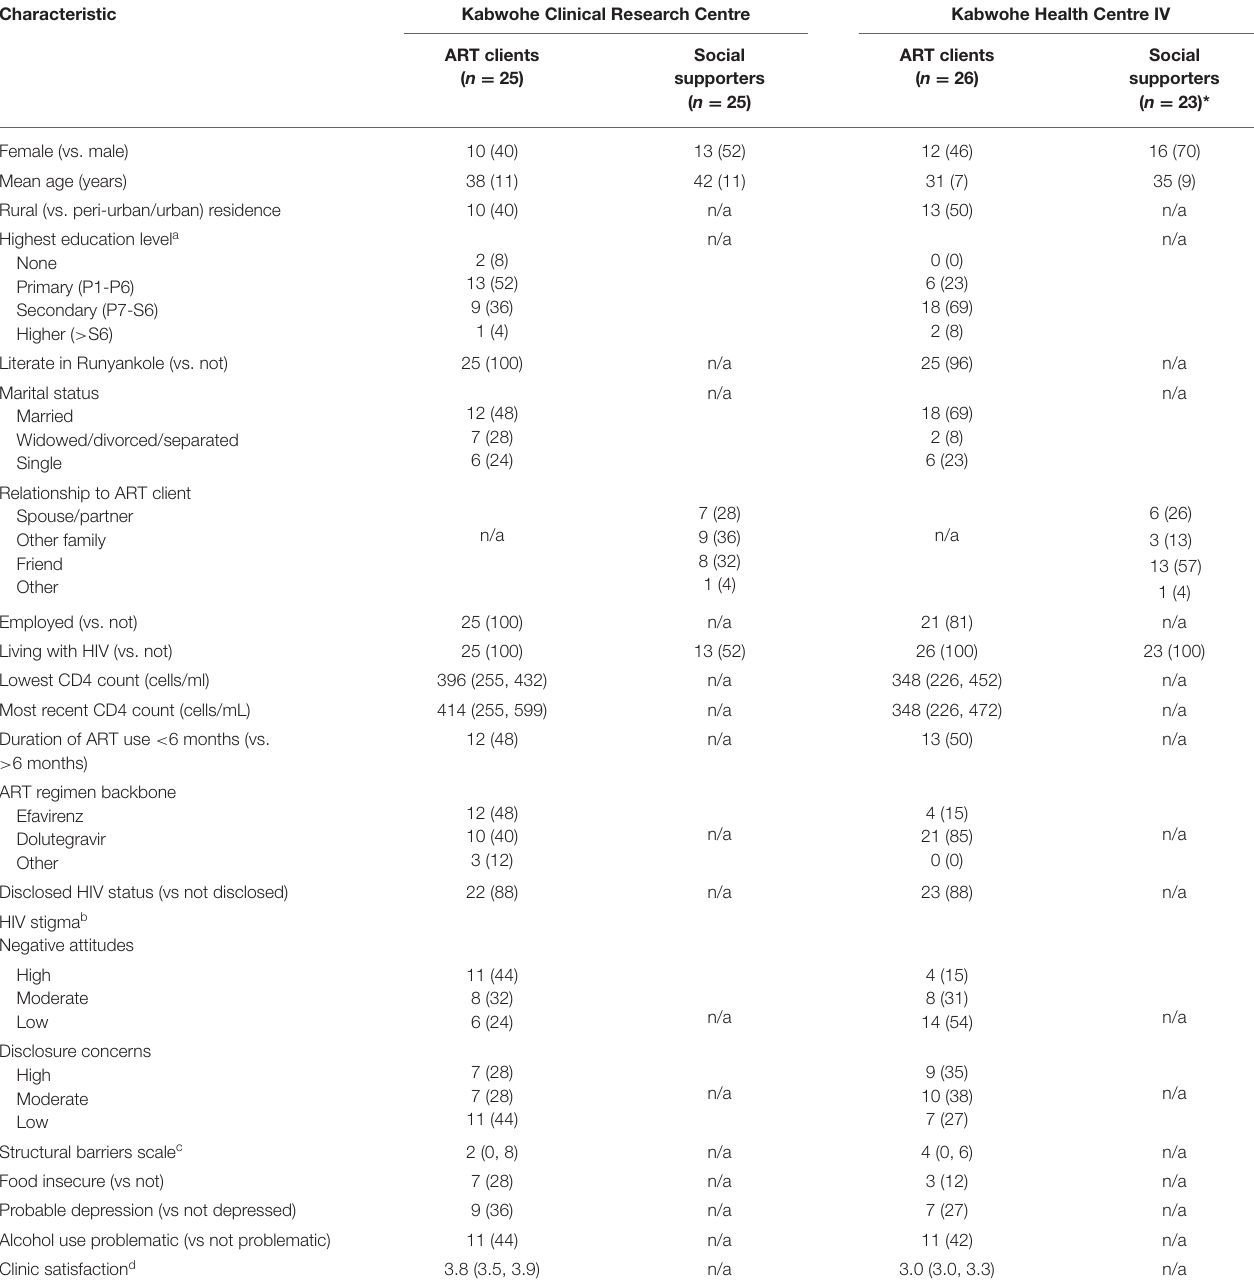
TABLE 1 | ART client and social supporter characteristics.